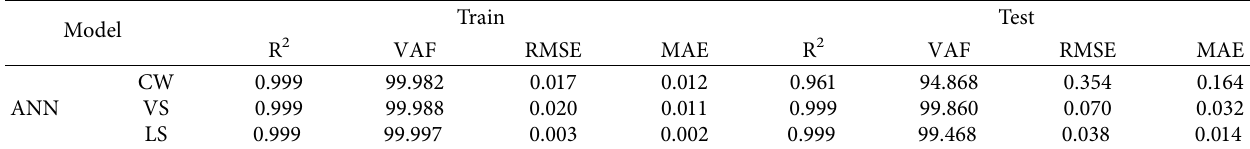
Table 10: Performance indicator values for building ANN models for outputs (CW, VS, and